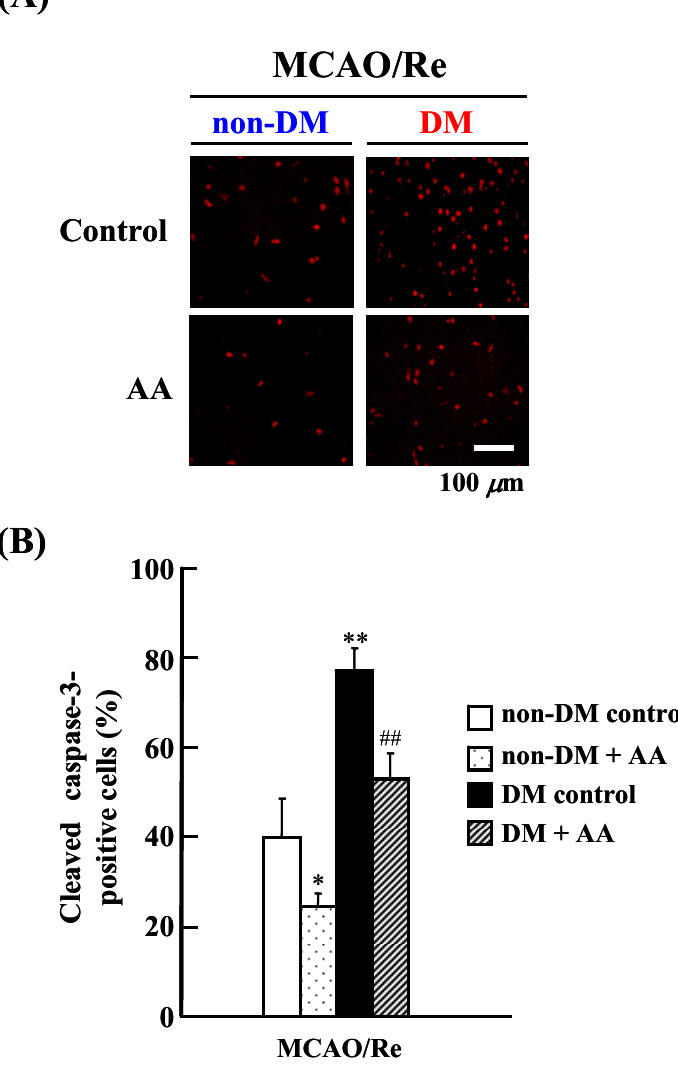
Figure 4. Effects of AA supplementation on cleaved caspase-3 after MCAO/Re in the brain of nondiabetic and diabetic rats. ( A ) Representative photographs of cleaved caspase-3 immunostaining in the cortex coronal sections of nondiabetic and diabetic rats; ( B ) Quantitative analysis of cleaved caspase-3 positive cells (fluorescence intensity in the cortex). The data are presented as mean ± SD ( n = 3–4). * p < 0.05, ** p < 0.01 compared with the nondiabetic control group. ## p < 0.01 compared with the diabetic control group. DM in the figure denotes diabetic, while non-DM denotes